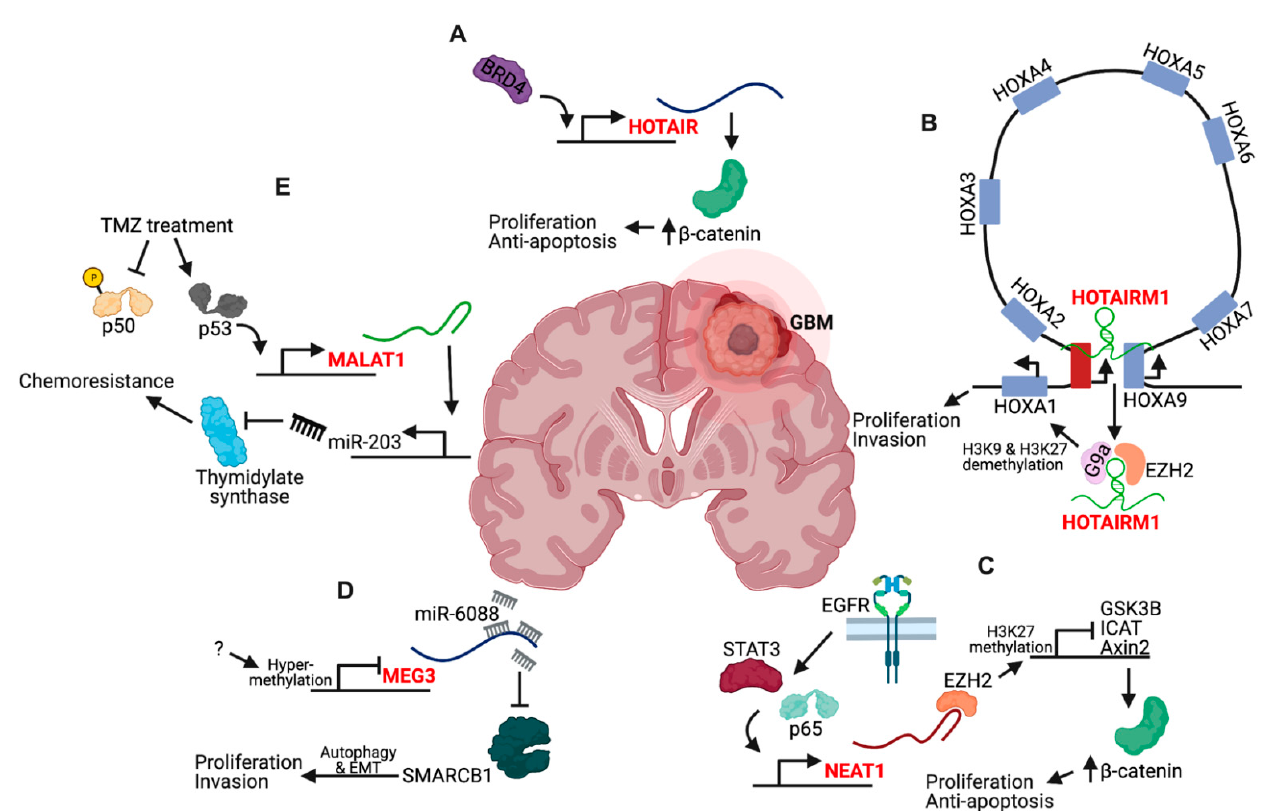
Figure 3. Mechanisms of lncRNAs in GBM. ( A ) The Bromodomain Containing 4 (BRD4) protein binds the HOTAIR promoter and regulates its expression for proliferative and antiapoptotic effects via β -catenin. ( B ) The HOTAIRM1 lncRNA is expressed within the HOXA gene cluster and promotes DNA looping by scaffolding with the HOXA9 gene to form a topologically associated domain. HOTAIRM1 also sequesters the G9a and EZH2 epigenetic modifiers, preventing methylation of the HOXA1 promoter and increasing its expression. ( C ) EGFR signaling stimulates the expression of NEAT1 in a STAT3- and p65-dependent manner. NEAT1 binds EZH2 and triggers the promoter methylation and decreased expression of GSK3B, ICAT, and Axin2, which normally sequester β -catenin in the cytoplasm to prevent transcriptional activity. ( D ) Hypermethylation of the MEG3 promoter results in decreased expression, which enables the accumulation of miR- 6088 and inhibition of SMARCB1. This promotes autophagy and an epithelial-to-mesenchymal transition (EMT) program that drives proliferation and invasion. ( E ) Therapeutic intervention with TMZ triggers Ser329 phosphorylation of p50, which prevents its recruitment to the MALAT1 promoter while promoting p53 recruitment. Upregulated MALAT1 drives miR-203 expression, which targets thymidylate synthase for degradation and contributes to therapeutic resistance.